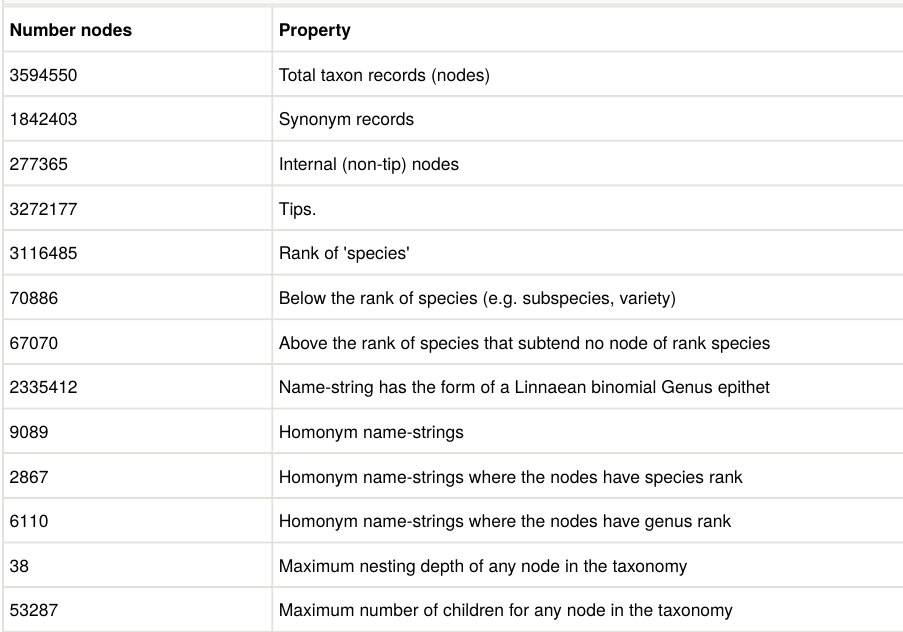
Summary of Open Tree Taxonomy